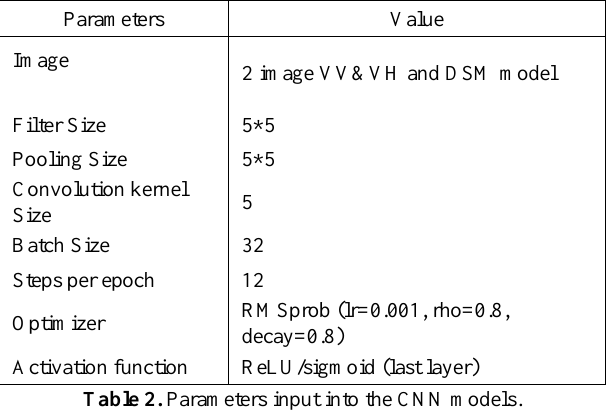
Table 2. Parameters input into the CNN models.